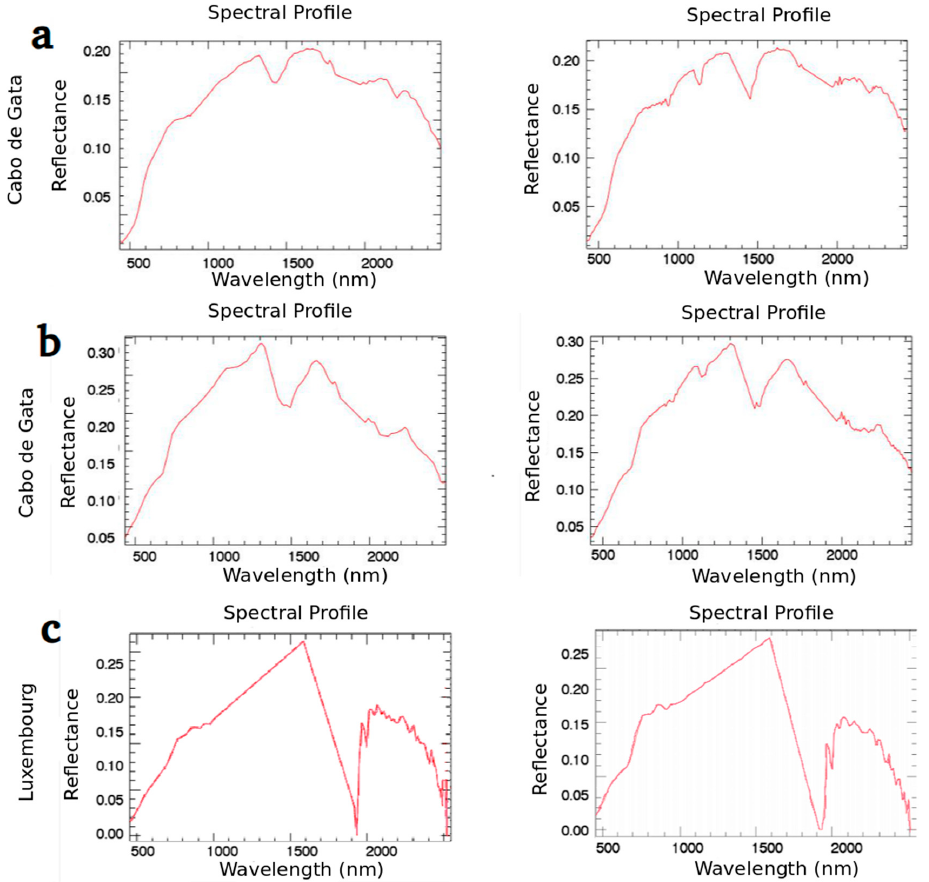
Figure 3. Soil spectral reflectance from airborne HyMAP and AHS ( left ) and spaceborne simulated EnMAP ( right ) imagery at: ( a ) Cabo de Gata iron-rich and clay-rich bare field area; ( b ) Cabo de Gata dry vegetation area; and ( c ) Luxembourg bare field area.